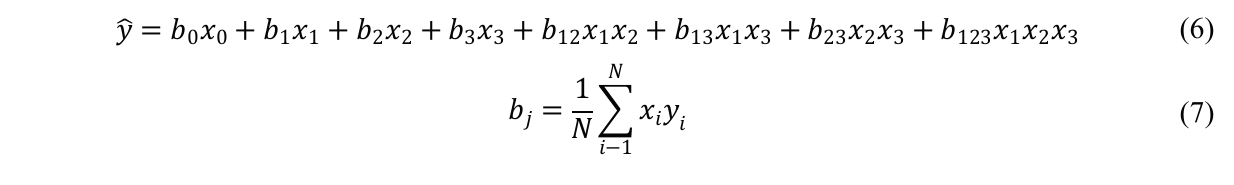
Table 4. The full factorial experiments design matrix (+1—high level, − 1—low level) and results of optimization